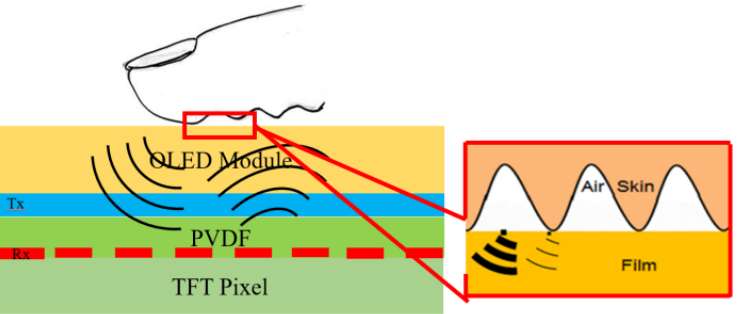
Figure 1. Ultrasonic fingerprint-sensor module.